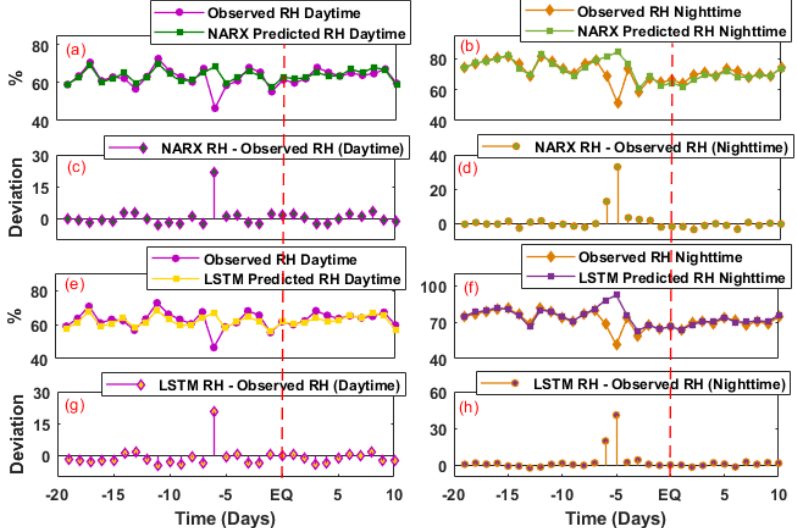
Figure 5. ( a ) Data variations between the observed RH daytime values and NARX-predicted RH daytime values, ( b ) Nighttime variations between the observed RH values and NARX-predicted RH, ( c ) Deviation of NARX-predicted RH daytime values from Observed daytime RH values, ( d ) Deviation of NARX-predicted RH nighttime values from Observed nighttime RH values, ( e ) Time series data variations between observed RH daytime values and LSTM train RH daytime values, ( f ) Nighttime variations between observed RH values and LSTM train RH, ( g ) Deviation of LSTM-predicted RH daytime values from Observed daytime RH values, ( h ) Deviation of LSTM-predicted RH nighttime values from Observed daytime RH values. The red dashed line shows the earthquake day.